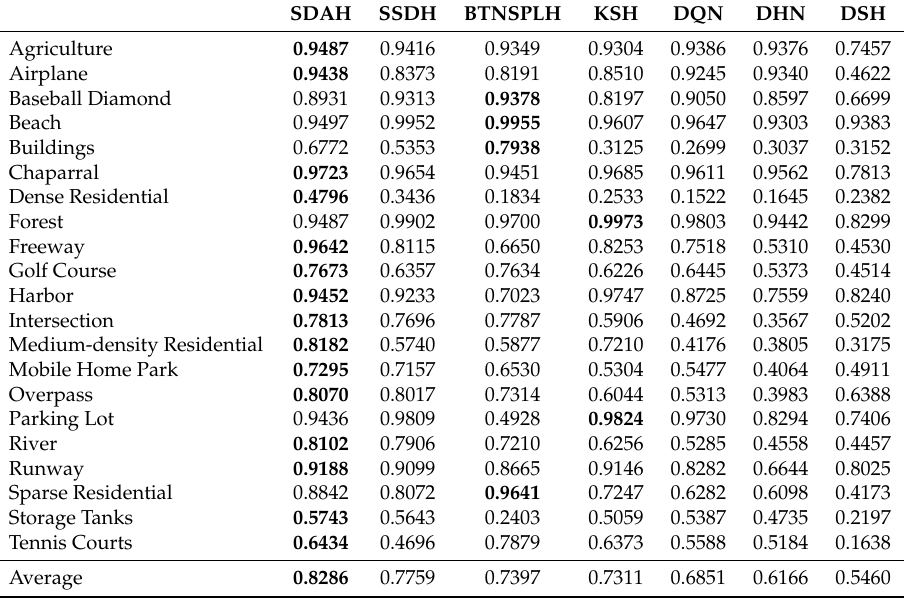
Table 7. Retrieval Mean average precision of different hash learning methods across 21 semantic categories in UCM archive counted by Top 50 results. The retrieval results are obtained by the hash codes with 128 bits. The values in bold mean that highest mean average precision of different methods. SDAH SSDH